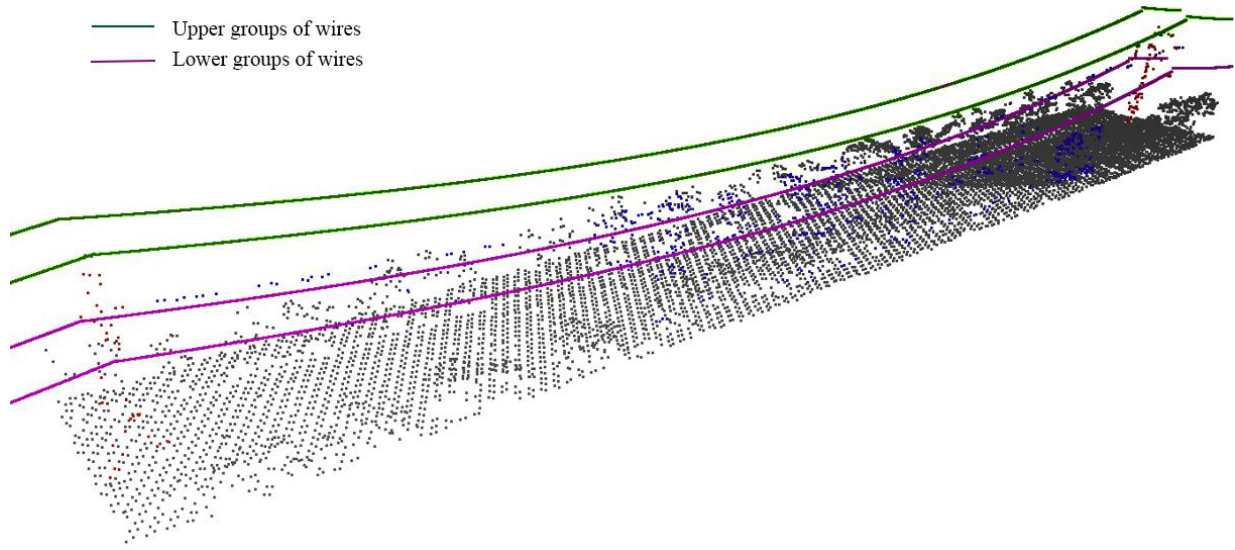
Figure 4. Simulated groups of wires obtained for the theoretical estimation of the catenary based on the maximum sag hypothesis calculation.